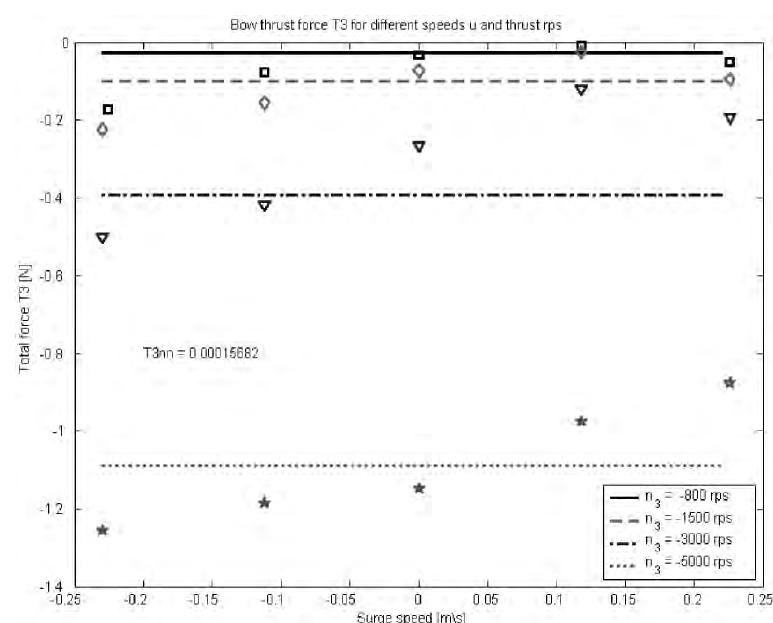
for forward and backward motion 3